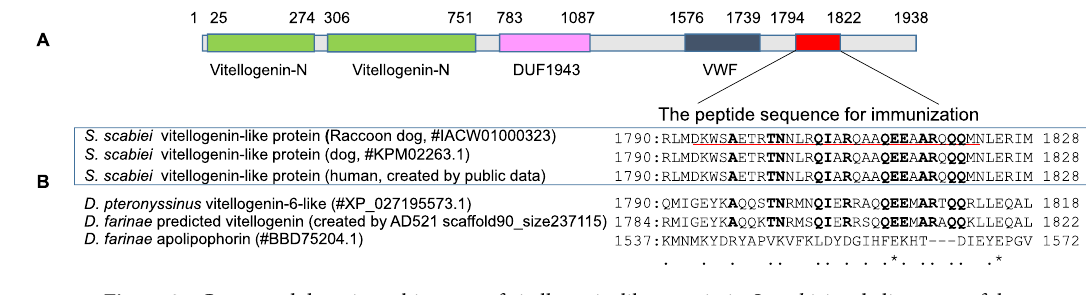
Figure 3. Conserved domain architecture of vitellogenin-like protein in S. scabiei and alignment of the sequences of proteins from the three types of scabies mites and two types of house dust mites. ( A ) The vitellogenin N (lipoprotein amino terminal region), DUF1943 (domain of unknown function), and VWD (von Willebrand factor type D domain) domains were predicted based on significant Pfam matches. ( B ) Comparison of sequences proximal to the selected peptide sequence in the vitellogenin-like proteins (red line) from S. scabiei, D. farinae (BBD75204.1), and D. pteronyssinus (XP_027195573.1). With respect to the amino acid sequence of the peptide used for immunization, the sequence homology was 45%–48% between S. scabiei and HDM and 83% between D. pteronyssinus and D. farinae. Boldfaced text or the use of an asterisk indicates perfect alignment; the dot indicates weak similarity.